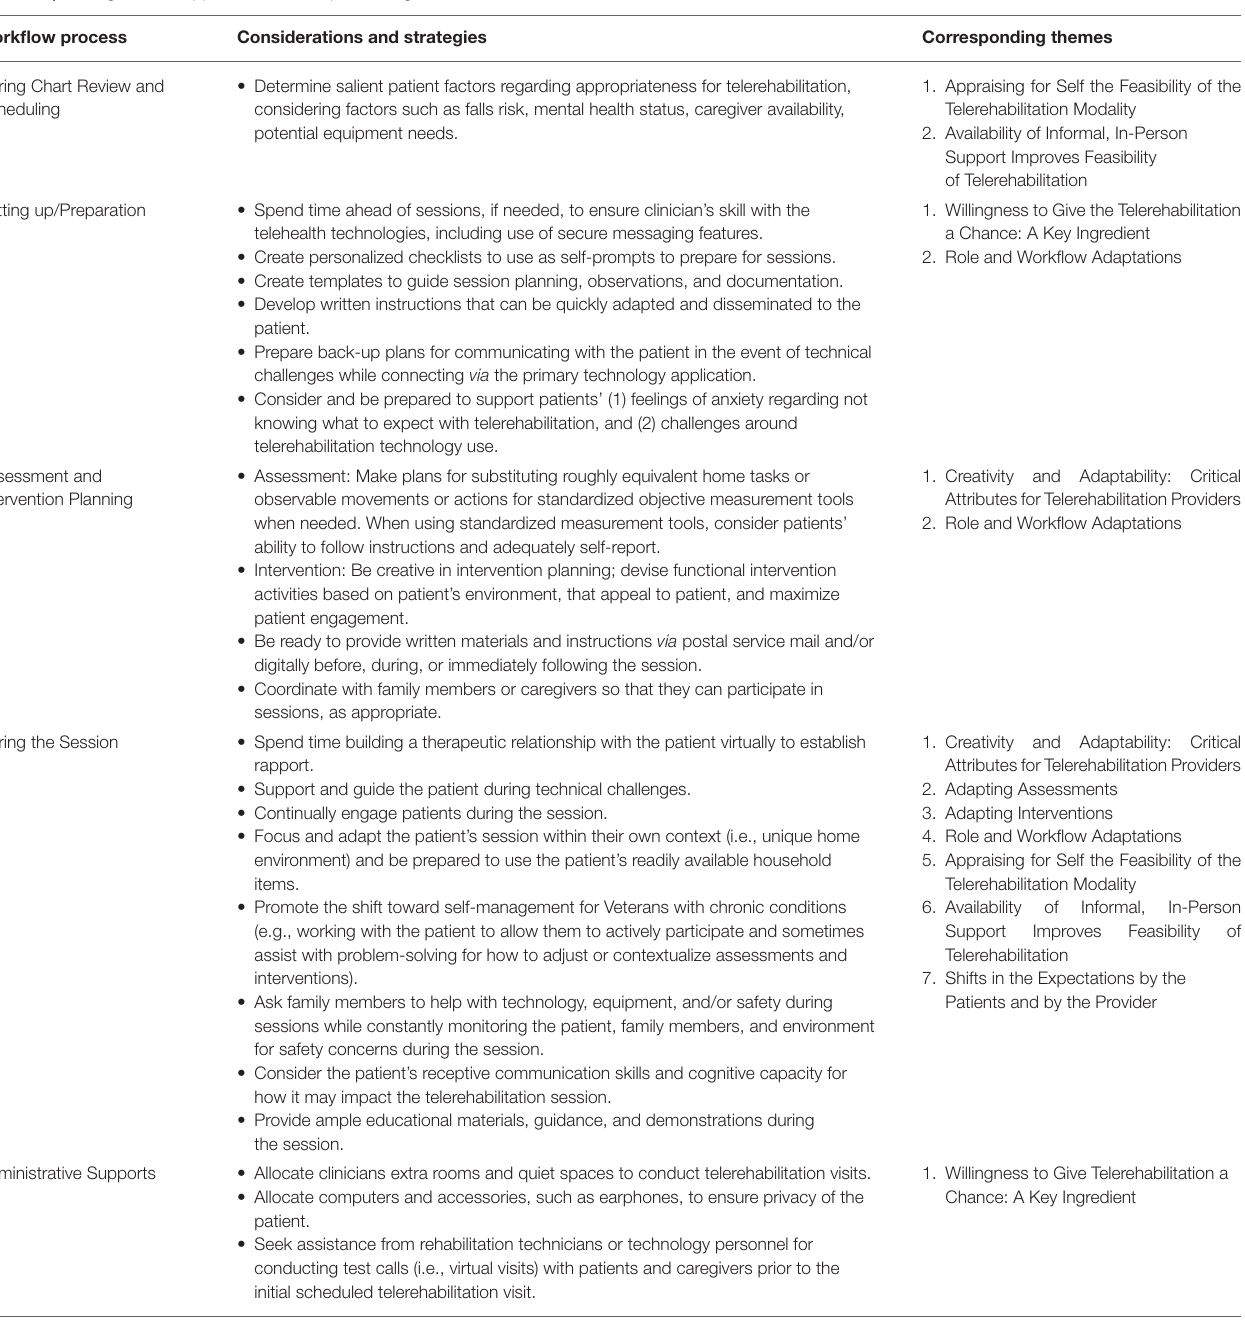
TABLE 3 | Strategies and supports used for implementing telerehabilitation